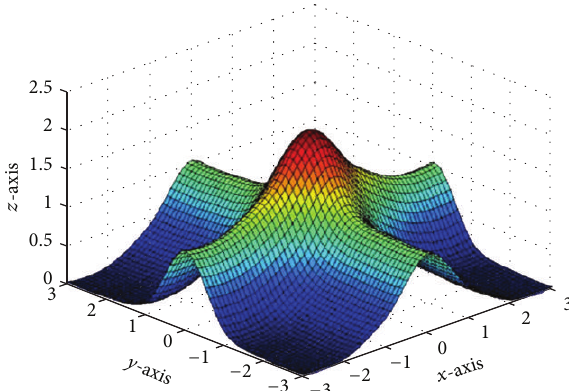
Figure 19: Positivity preserving by using the study of Abbas et al. [2] for positive data in Table 5.